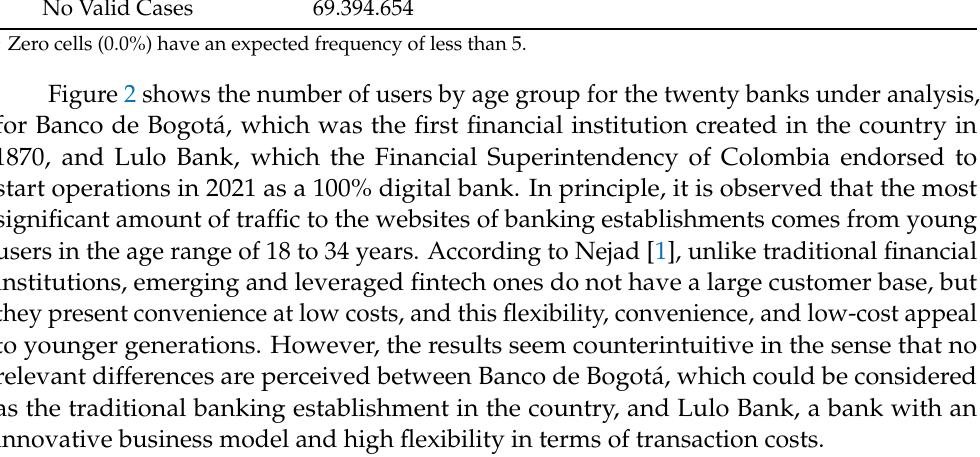
Table 1. Chi-square test gender and banking establishment. Value df Asymp. Sig. (2-Sided) Pearson Chi-Square 25.073,921 1 0.000 Likelihood